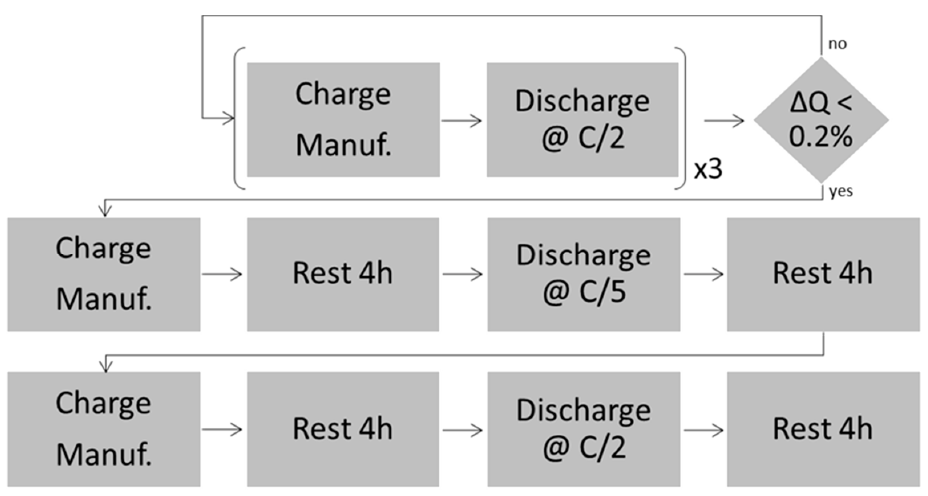
Figure 2. Initial conditioning characterization test (ICCT) formation test protocol.